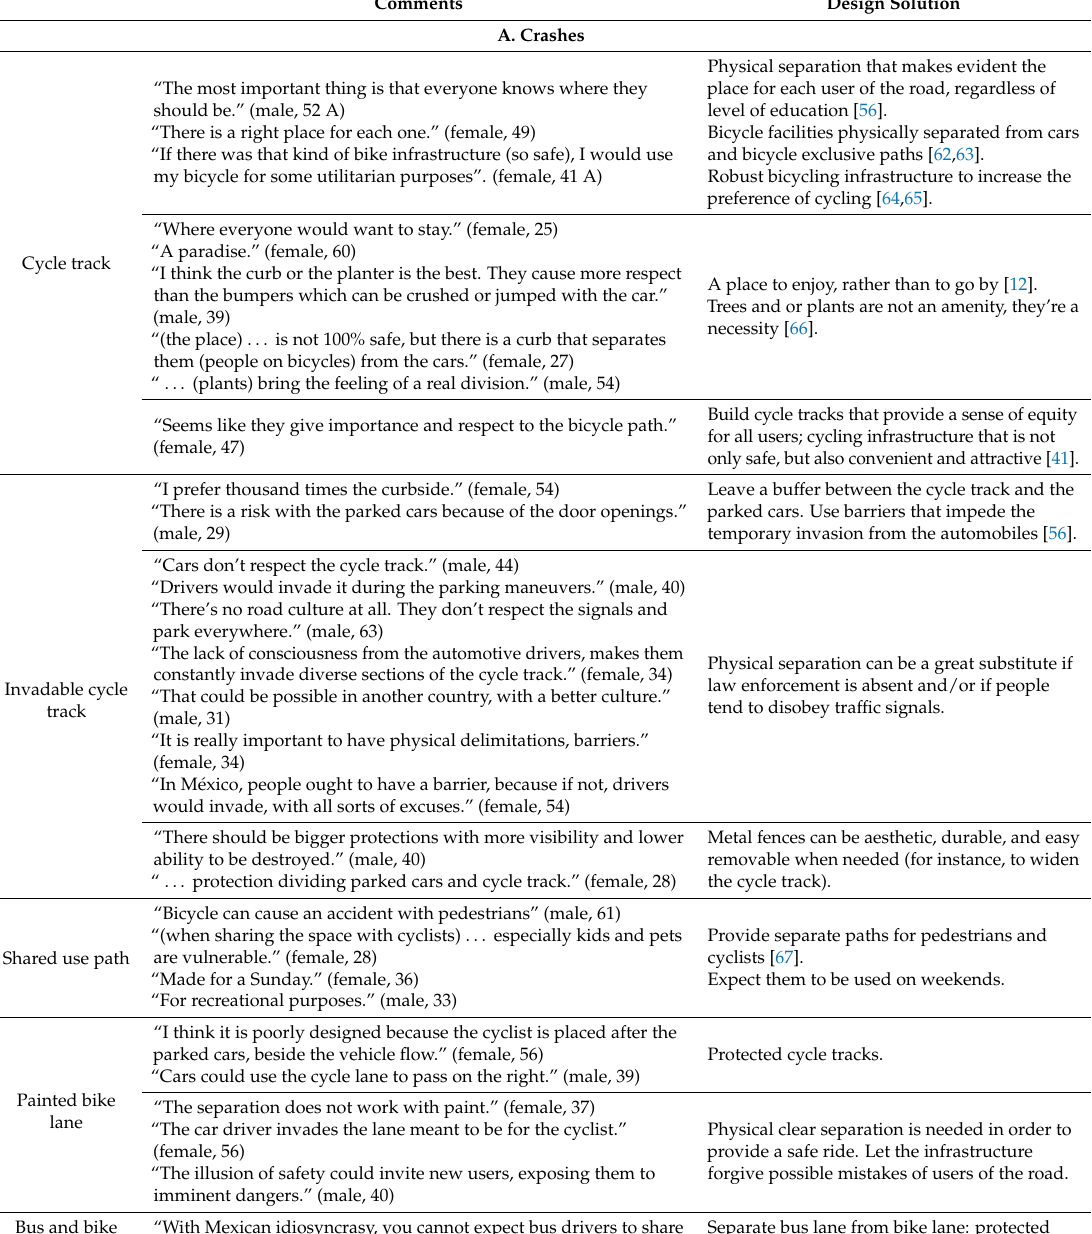
Table 4. Comments of participants regarding the types of infrastructure on the core areas (Phase Two): A. Crashes, B. Crime, C. Economic development, and design